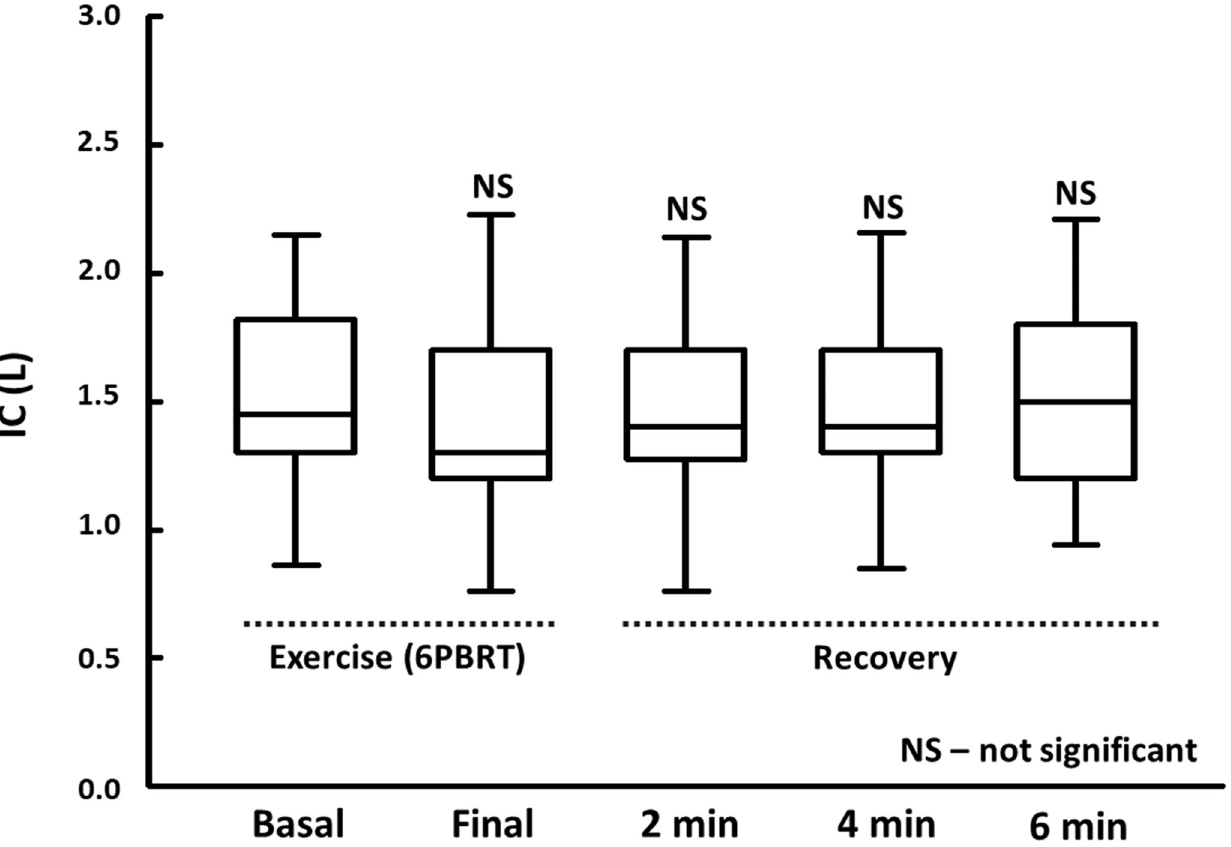
Fig 3. Serial IC measurements during and after 6-PBRT (repeated measures ANOVA). Abbreviations: NS, not significant; IC, inspiratory capacity; L, liters; 6-PBRT, six-minute pegboard and ring test; min, minutes.